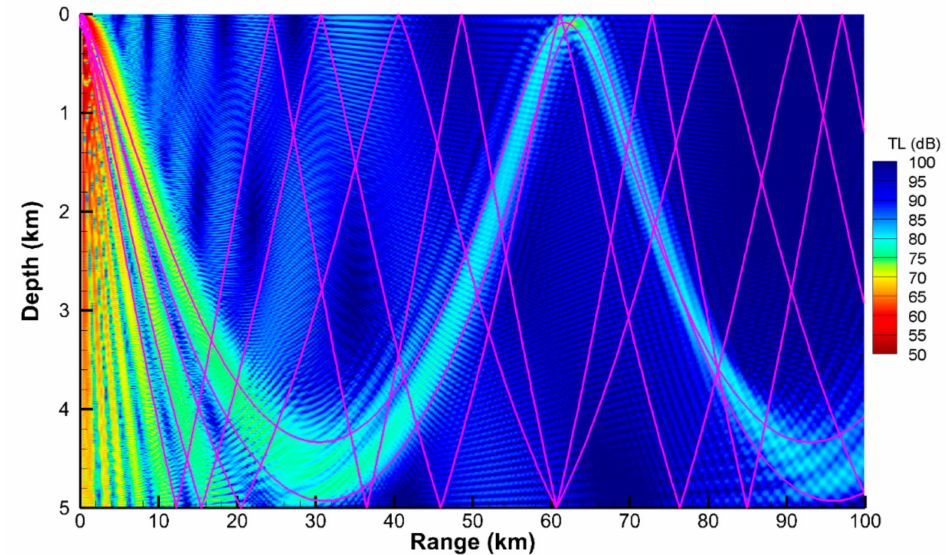
Figure 10. TL contours and rays obtained from the VWI model using the 2nd-order FDM and the BELLHOP model,